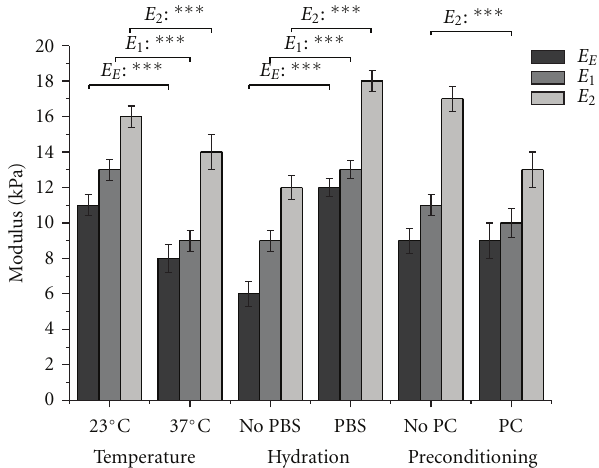
Figure 9: Relaxation moduli of ring-shaped collagen gels as a function of temperature (experiments performed either at 23 ◦ C or 37 ◦ C), hydration (either with or without a PBS solution), and mechanical preconditioning (either with or without mechanical preconditioning PC). E E , E 1 , and E 2 are, respectively, the elastic and the viscous moduli of the gels considered in the viscoelastic model. The sum of all 3 moduli is the instantaneous linear modulus E R 0 at a strain of 10%. Values are expressed as mean ± standard